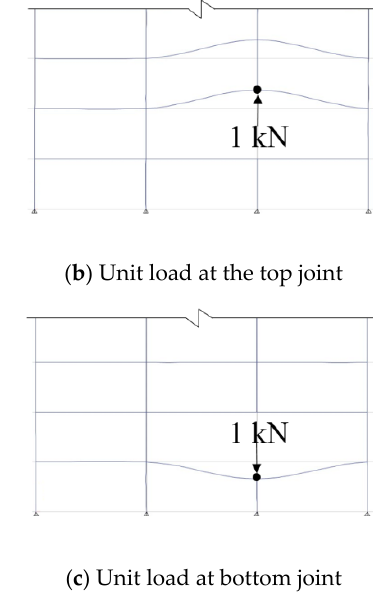
Figure 17. Description of the proposed analysis procedure.